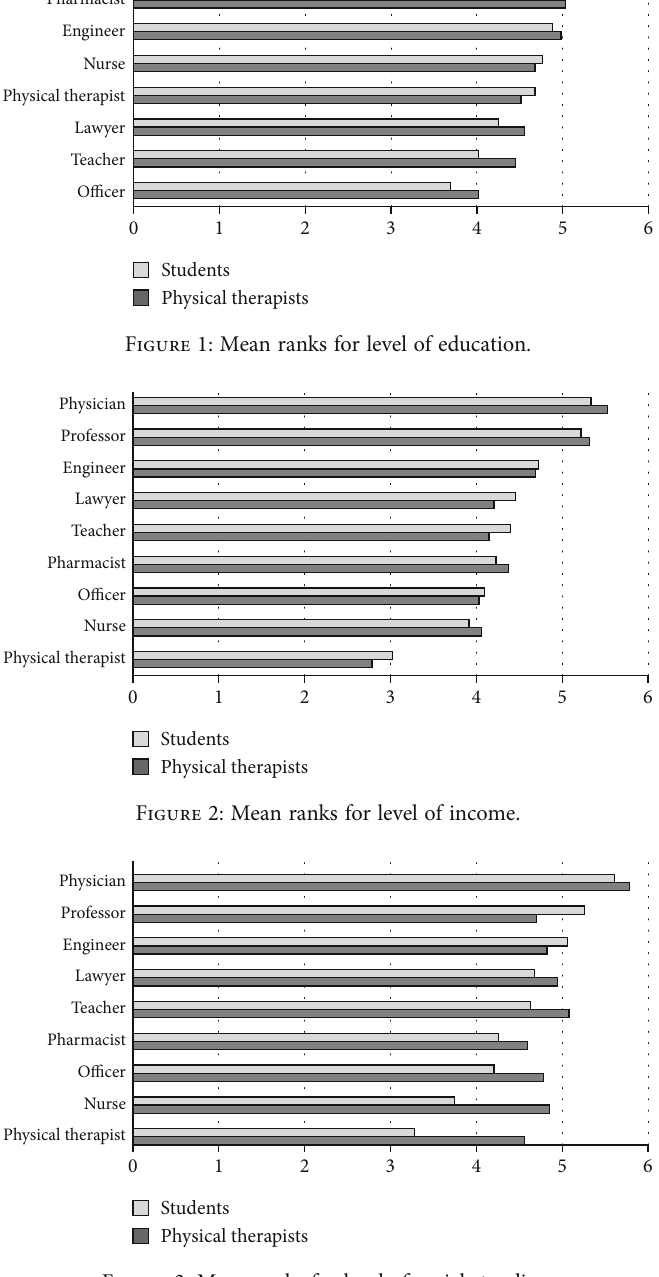
Figure 3: Mean ranks for level of social